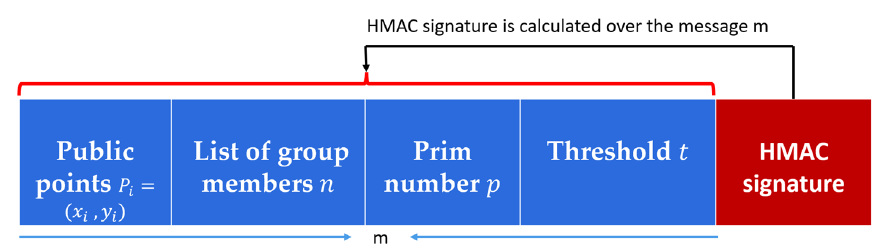
Figure 5. The proposed key reconstruction message structure.